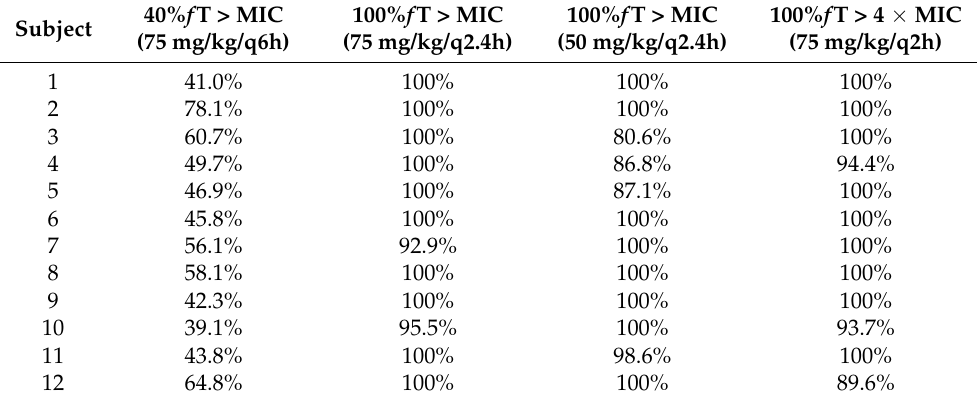
Table 1. The actual target attainment of different PK/PD targets in sepsis rats receiving various meropenem dosing regimens.